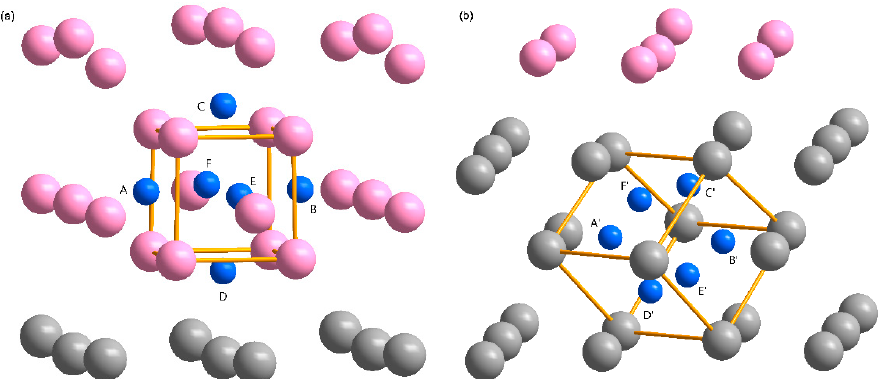
Figure 7. The atomic configurations of the H clusters in ( a ) Li(100) / Ta(100) and ( b ) Li(110) / Ta(110) bilayers. The atomic configurations of the H clusters in the Li and Ta layers are mirror images of each other, therefore, the configurations in the Li layer of the Li(100) / Ta(100) bilayer and that in the Ta layer of the Li(110) / Ta(110) bilayer are displayed here for a brief description. The pink, gray, and blue atoms represent the Li, Ta, and H atoms, respectively. The hollow box represents a vacancy.